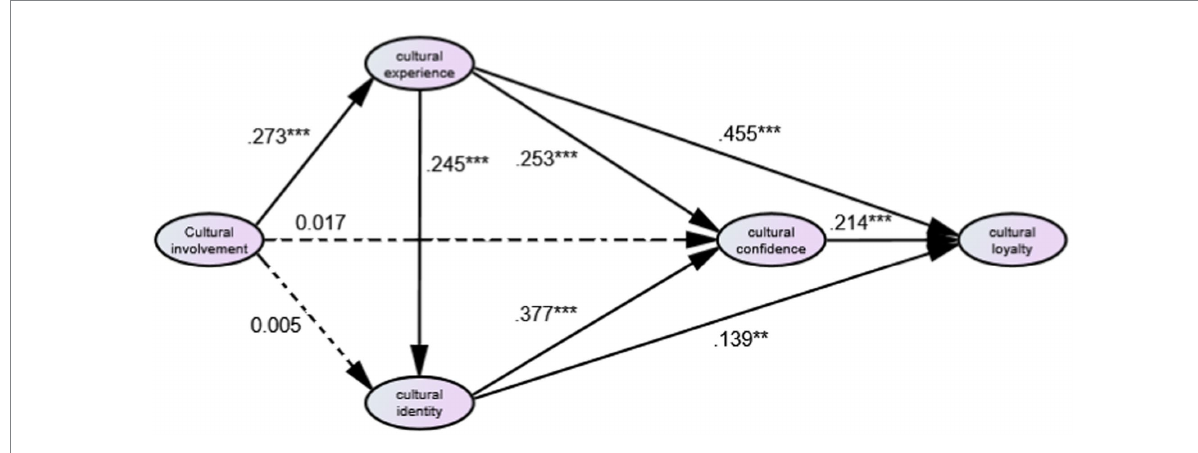
FIGURE 2 Structure model and path coefficient. * p < 0.05,** p < 0.01, *** p <